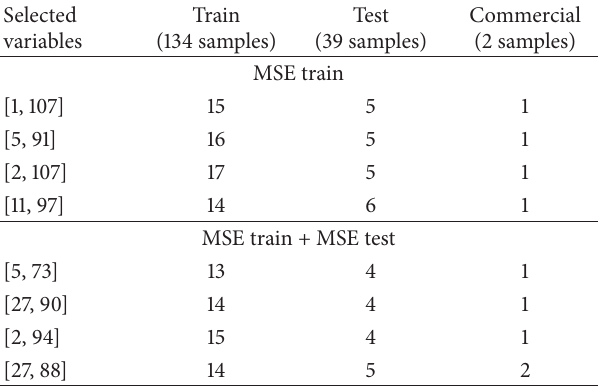
Table 13: Classification errors using GA + SVM: low concentration. Selected